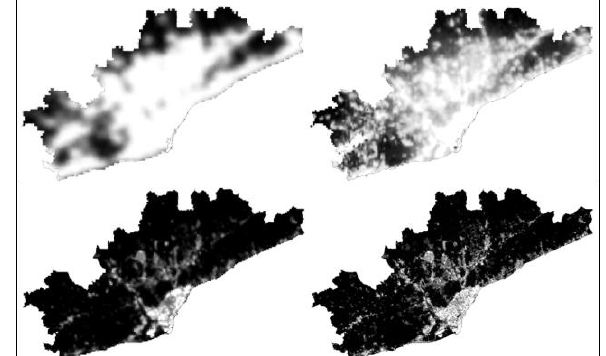
Figure 3. Night lights obtained by DMSP-OLS, Black Marble,